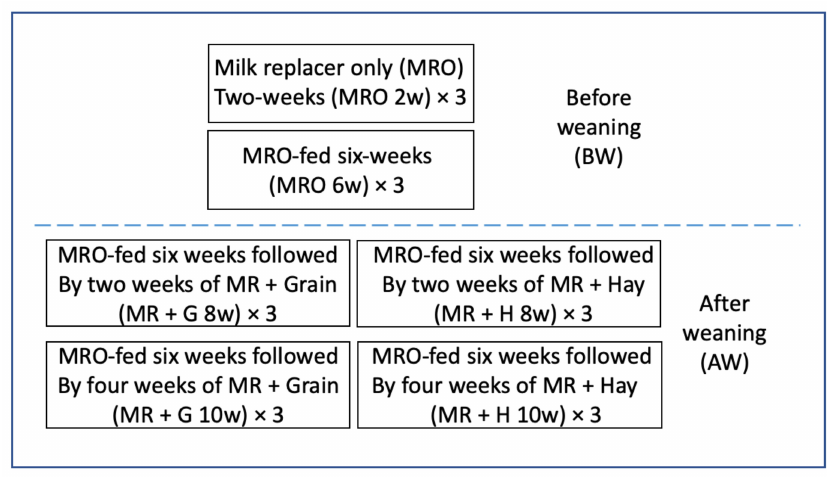
Figure 1. Diagram describing feeding scheme of the 6 developmental groups evaluated. 18 calves were divided among 6 groups of 3 calves each (6 × 3). Groups above the dashed horizontal line represent those preweaning, and groups below the dished line represent those